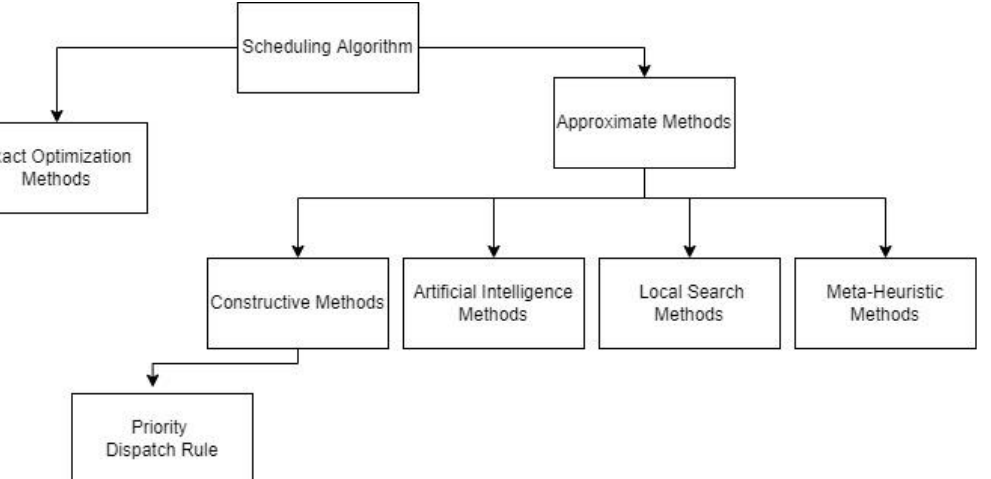
Figure 3. Types of scheduling algorithms. Adapted with permission from Ref. [20]. Copyright 2019 Yisheng Zou.